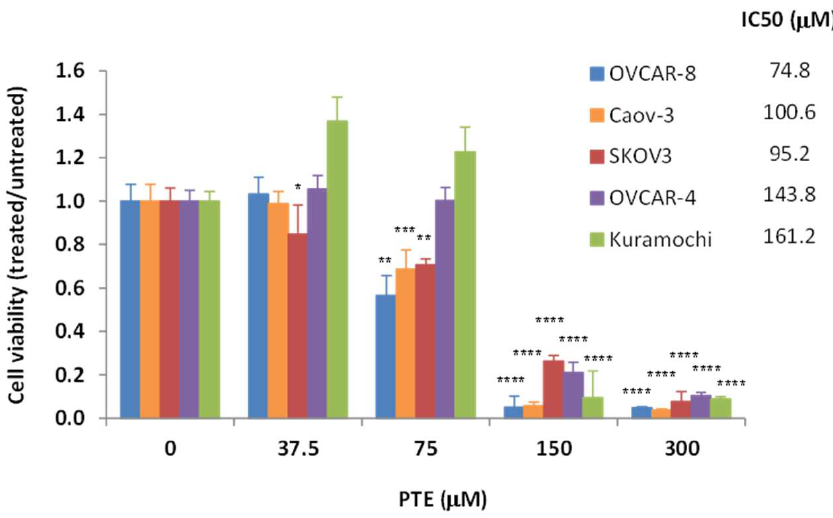
Figure 1. Pterostilbene (PTE) inhibits ovarian cancer cell viability. Cells were treated with vehicle (DMSO) or PTE (37.5–300 µ m) for 72 h. Cell viability was determined using MTT assay. Data (DMSO) or PTE (37.5–300 μm) for 72 h. Cell viability was determined using MTT assay. Data are expressed as the ratio to control treated with vehicle (DMSO). IC 50 values of pterostilbene were determined by the Chou-Talalay method. Results are representative of 3 or more experiments, each with 3 or more replicates. *, p < 0.05, **, p < 0.005, ***, p < 0.0005, ****, p < 0.0001, versus control treated